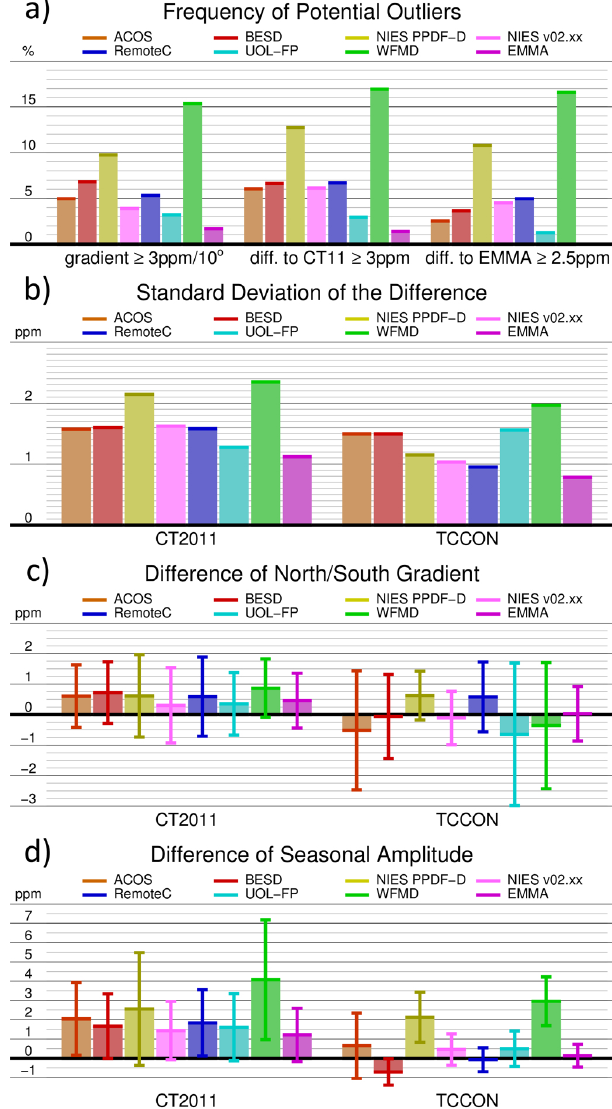
Fig. 4. Performance statistics (based on level 3 data) of the seven individual retrieval algorithms and EMMA. From top to bottom: (a) frequency of potential outliers defined as unrealistically large spatial gradient, large deviation from CT2011, and large deviation from EMMA; (b) standard deviation of the difference (STDD) to CT2011 and TCCON; (c) difference of the north/south gradient to CT2011 and TCCON (average and standard deviation); (d) differ- ence of the seasonal amplitude to CT2011 and TCCON (average and standard